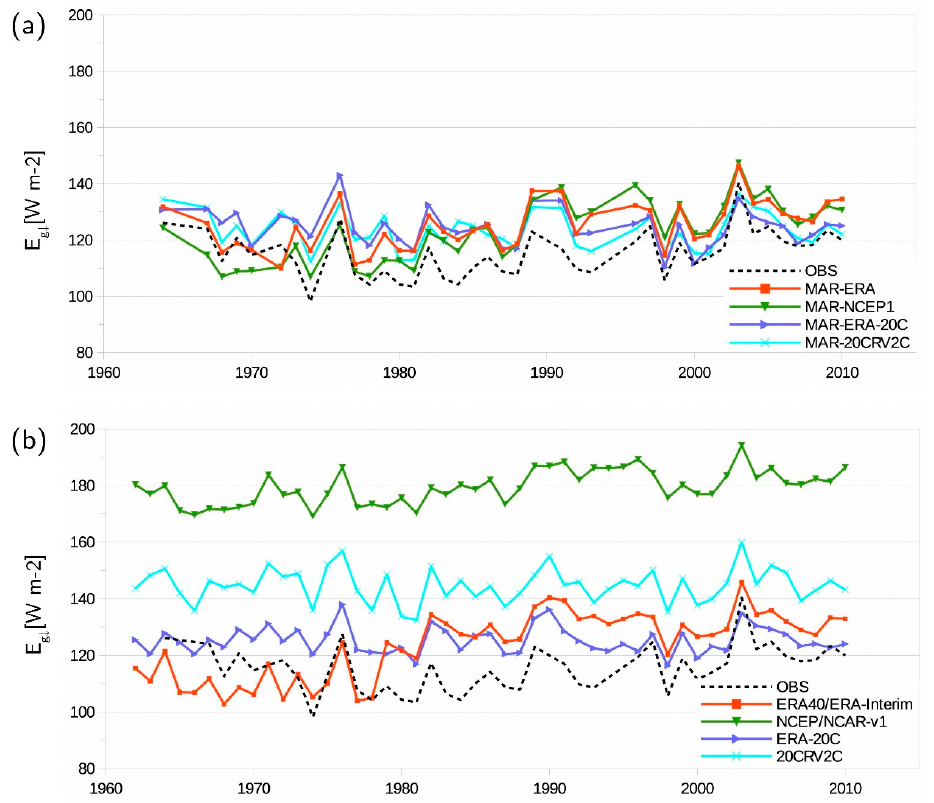
Figure 2. Time series of the observed (at Saint-Hubert) and modelled E g ↓ (at the nearest grid point to Saint-Hubert).